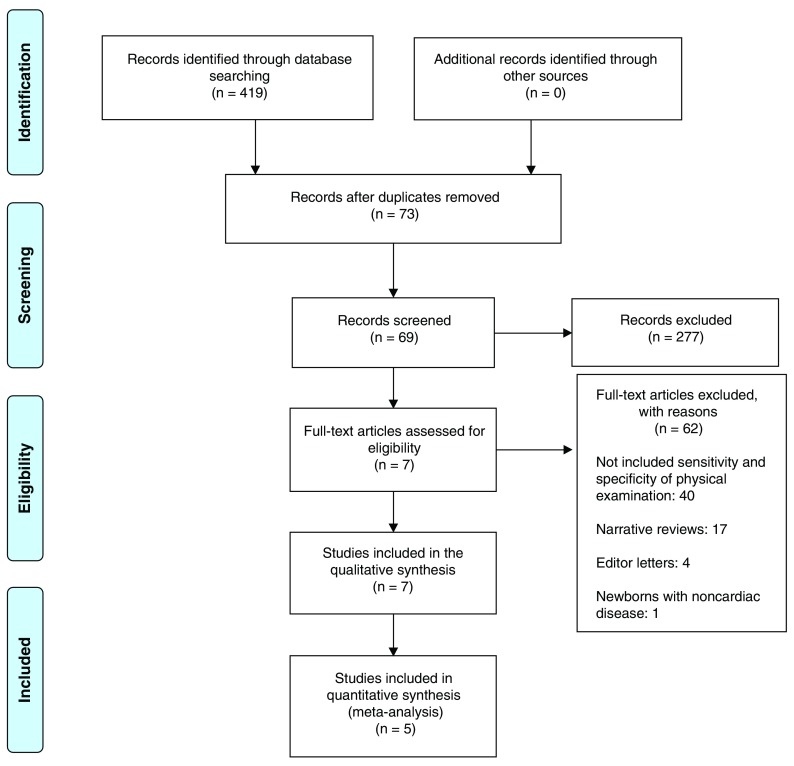
PRISMA flow diagram
13.